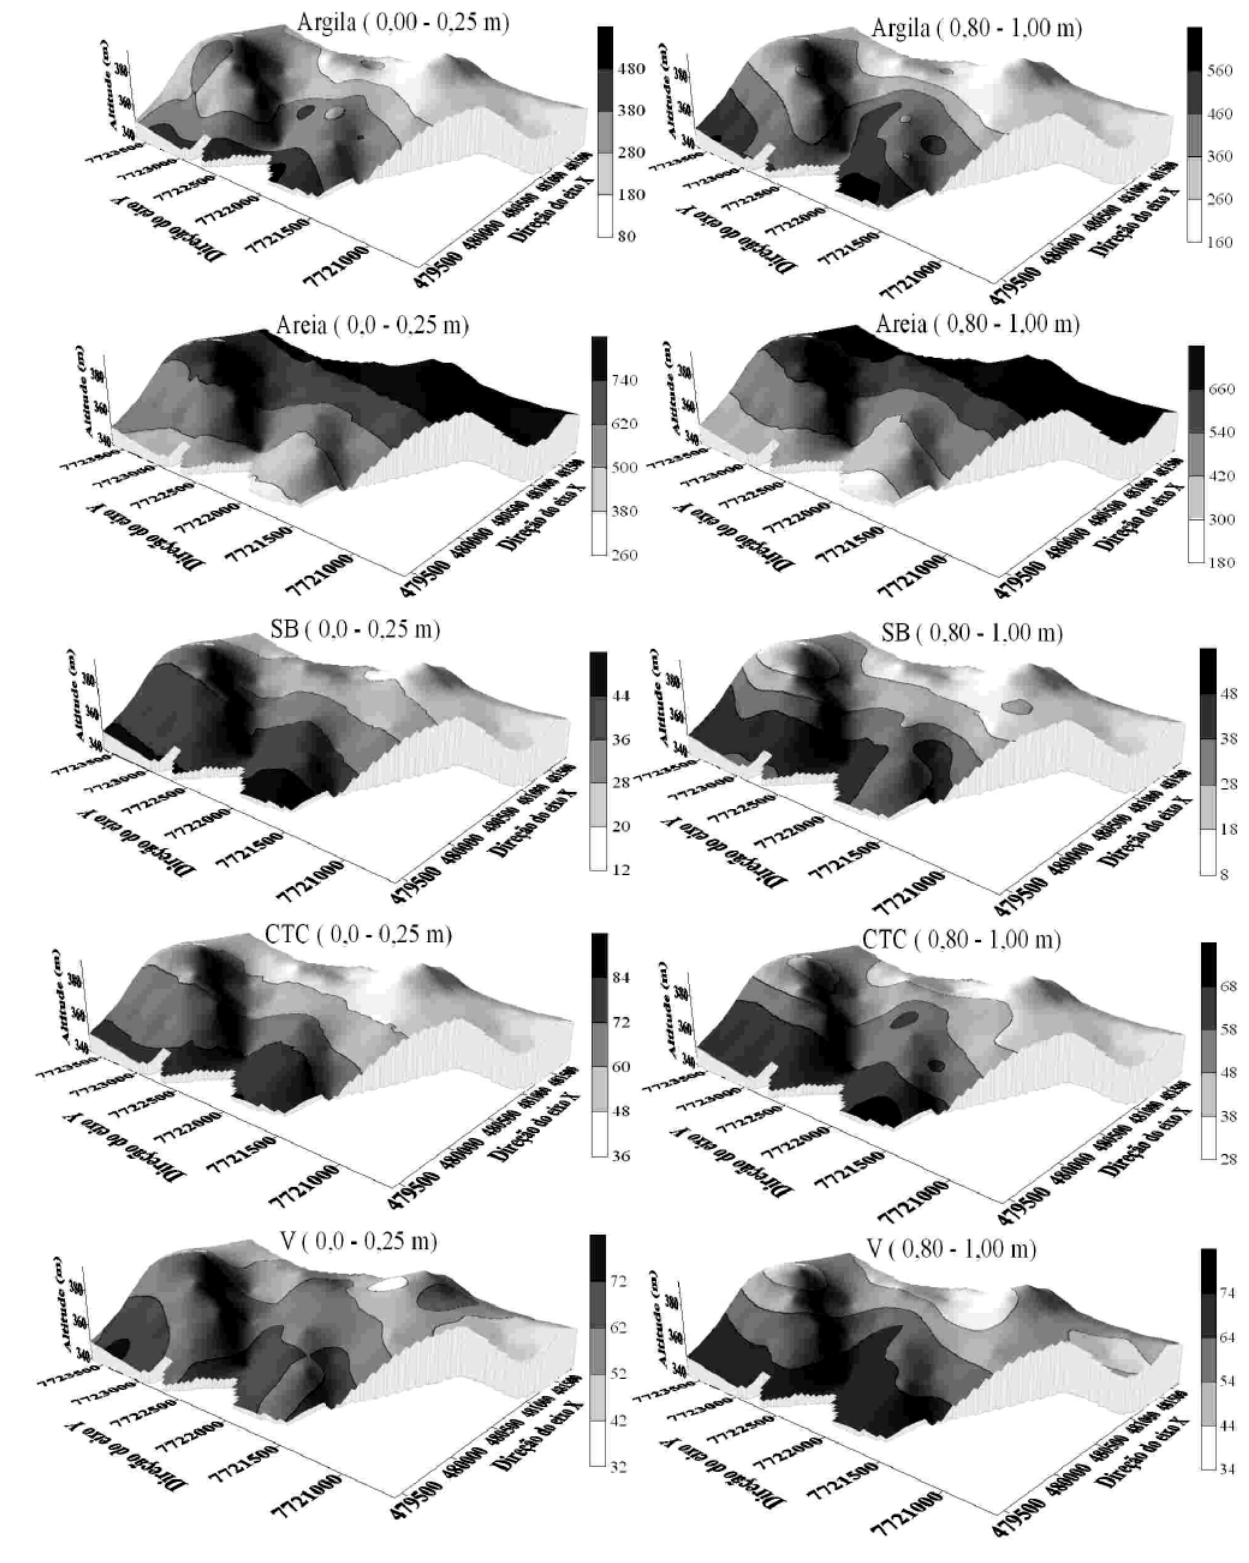
Figura 4. Mapas de krigagem do conteúdo de areia e argila do solo (g kg -1 ), da soma de bases, da capacidade de troca de cátions (mmol dm -3 ) e da saturação de bases (%), nas profundidades de 0,00–0,25 m e c 0,80–1,00